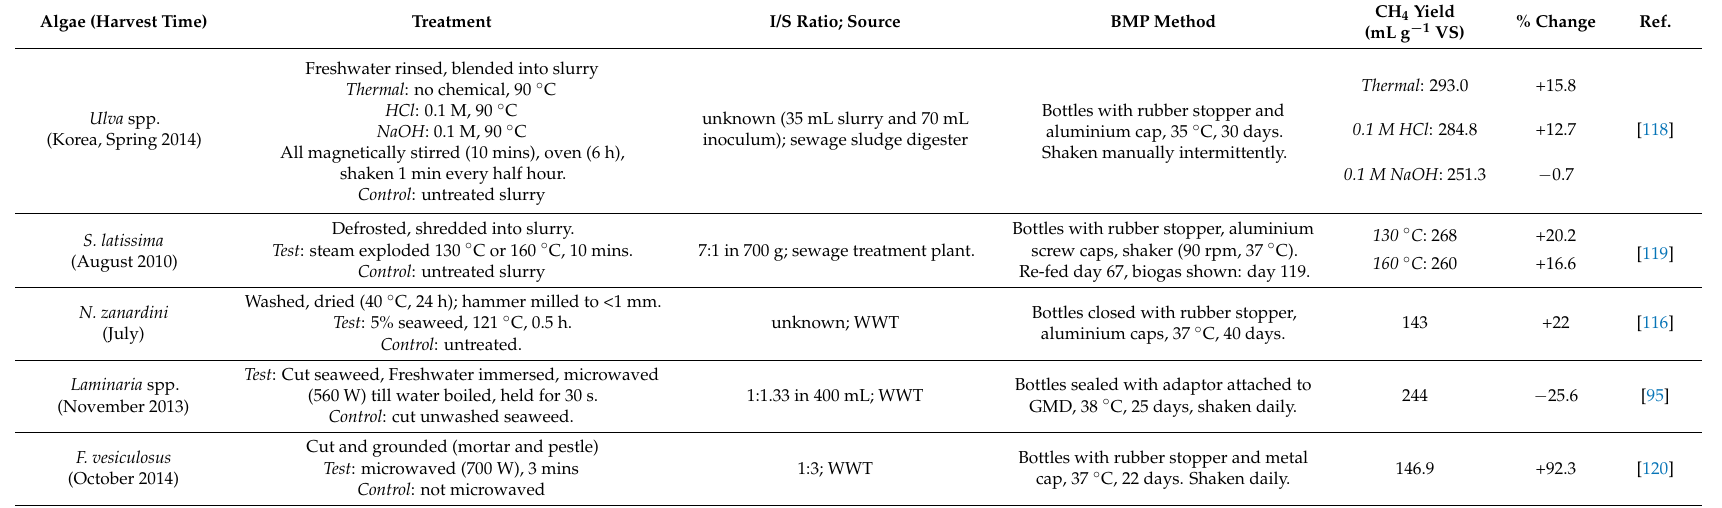
Table 4. Methane yields following thermal pre-treatment of seaweed.